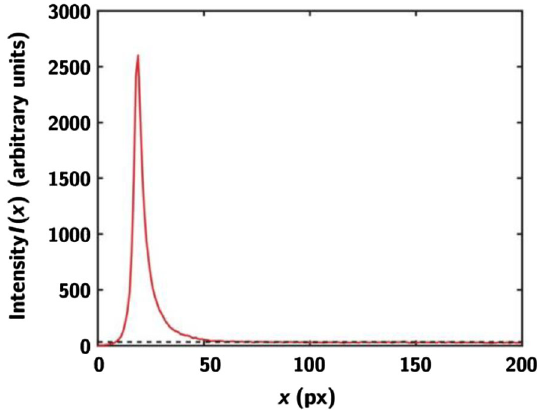
FIG. 7. Damage profile extraction. Intensity normal to the crack profile. The horizontal dashed line shows the background level in the